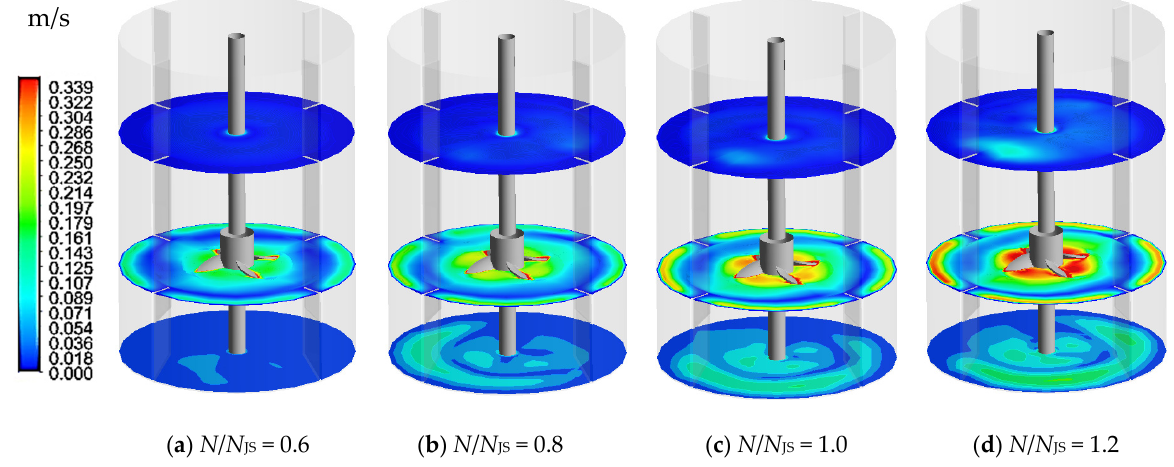
Figure 7. Velocities in stationary frame contours in the reactor top view at 0.139, 0.056 and 0.001 suspension height.